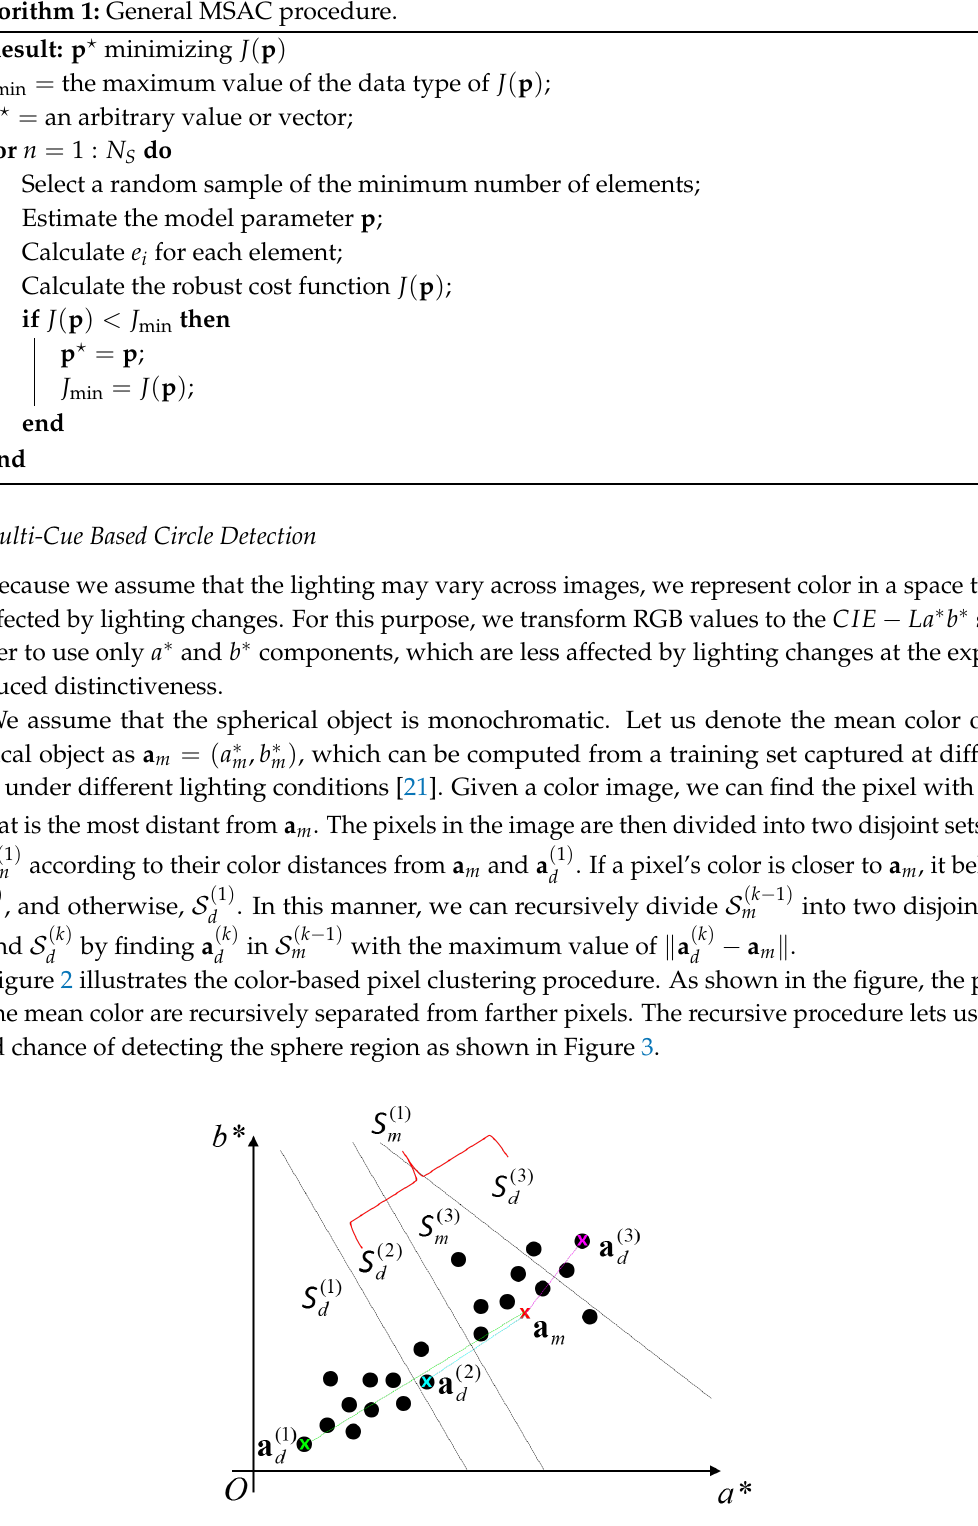
Figure 2. Color-based pixel clustering. The black circles represent pixel colors. The most distant color ( 1 ) from a m is a , and the pixels are divided into two disjoint sets S d ( 2 ) S ( 3 ) S ( 3 ) , and S . The black dotted lines represent the boundary between different sets of pixels. m , d d Refer to the text for more detail. Best viewed in